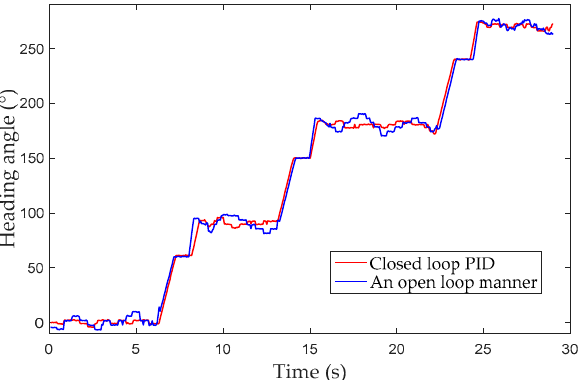
Figure 20. The experimental waypoint trajectory. The red stars represent the waypoints. We show the four waypoints A (20, 20), B (130, 20), C (130, 90), and D (20, 90), and the reference trajectory (blue lines; a precise rectangle). The red and green curves are the trajectory of the robot with closed loop PID and an open loop manner as recorded by the vision localization system, respectively.